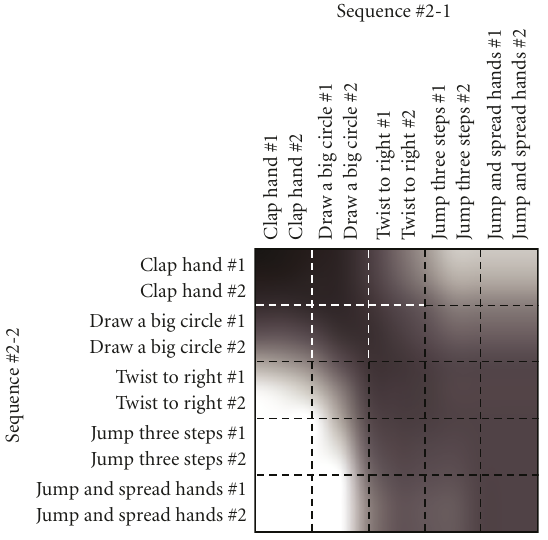
Figure 8: Similarity among motion